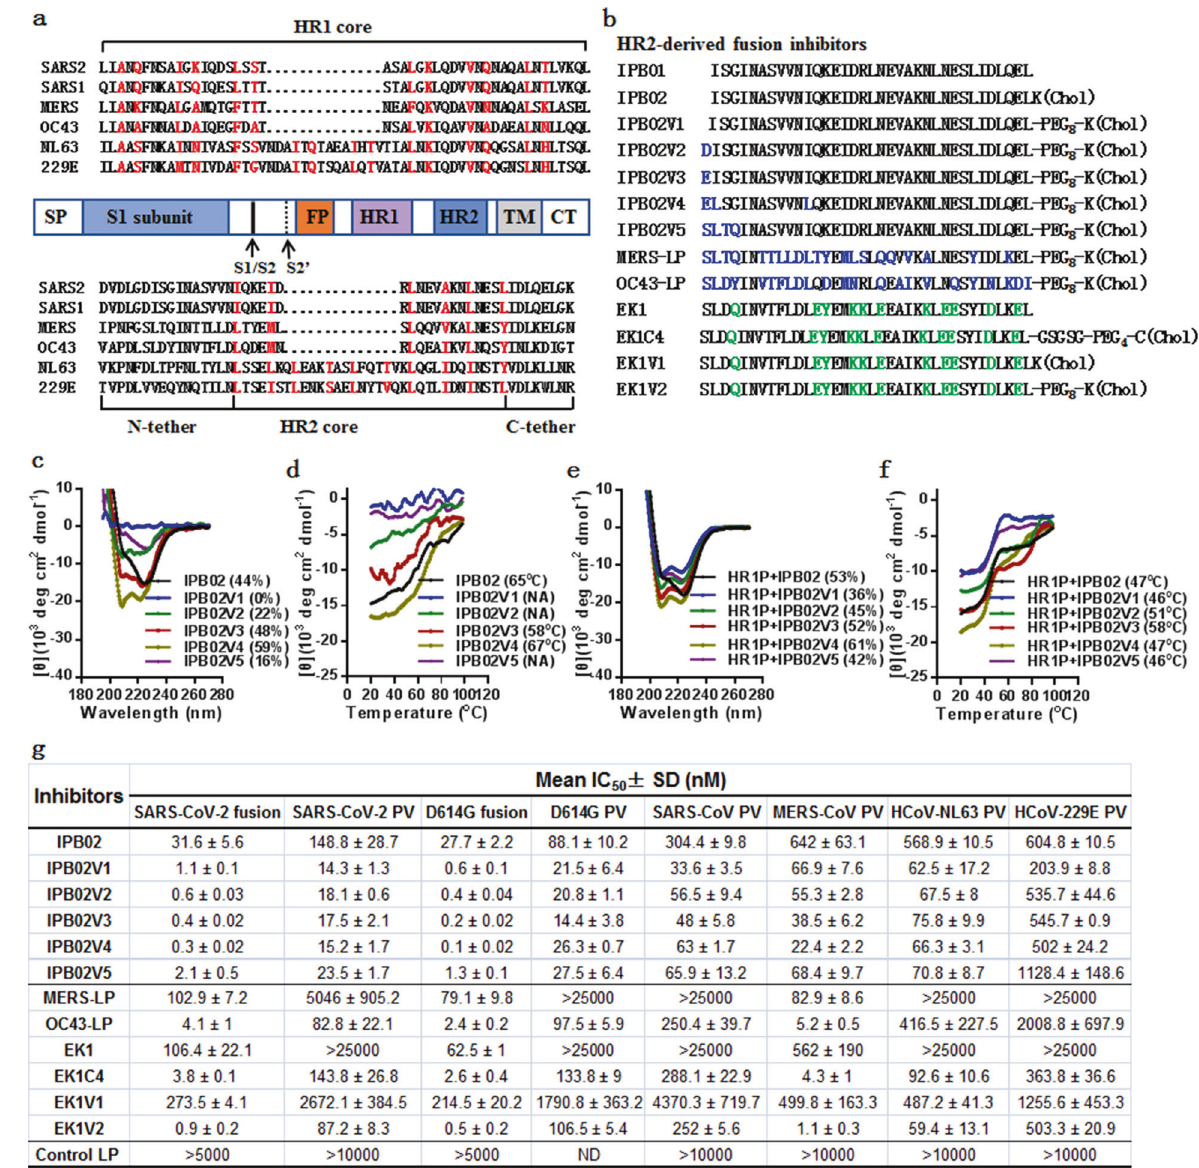
Fig. 1 Design and characterization of potent and broad-spectrum fusion inhibitors against divergent human coronaviruses. a Schematic diagram of functional domains of the S protein. SP signal peptide, FP fusion peptide, HR1 heptad repeat 1, HR2 heptad repeat 2, TM transmembrane domain, CT cytoplasmic tail. The S1/S2 and S2 ’ cleavage sites are marked with arrows. The HR1 and HR2 core sequences of representative HCoVs are listed, and the potential residues mediating the HR1 – HR2 interactions within the 6-HB core structure are colored in red. b HCoV HR2-derived fusion inhibitor peptides and lipopeptides. The residues marked in blue indicate the amino acid changes relative to the template sequence in IPB02. The residues in green indicate the amino acid changes relative to the template sequence in OC43-LP. Chol cholesterol, PEG 8 8-unit polyethylene glycol, PEG 4 4-unit polyethylene glycol, GSGSG a fl exible amino acid linker. c – f Secondary structure and binding stability of IPB02-based fusion inhibitor lipopeptides. The α -helicity and thermostability of lipopeptides alone ( c , d ) or in complexes with the SARS-CoV-2 HR1 target mimic peptide HR1P ( e , f ) were determined by CD spectroscopy, with the fi nal concentration of each lipopeptide being 10 μ M. The experiments were performed two times, and representative data are shown. g The inhibitory activity of various fusion inhibitors against SARS-CoV-2 and other human CoVs. Both dual-split-protein (DSP)-based cell – cell fusion assay and pseudovirus (PV)- based single infection assay were repeated three times, and data are expressed as the means ± standard deviations (SD). D614G represents the SARS-CoV-2 S protein-bearing D614G mutation and characterized. Interestingly, OC43-LP exhibited high inhibitory HCoV-229E pseudoviruses. Recently, the HCoV-OC43 HR2-derived potencies against all CoVs being tested; especially, it was a highly peptide EK1 and its lipid-derivative EK1C4 were reported as pan-CoV active inhibitor of MERS-CoV (Fig. 1g and Supplementary Fig. S5). fusion inhibitors. 5 To reveal the structure – activity relationship of Herein, the unconjugated EK1 peptide only showed weak inhibition various CoV fusion inhibitors, we further synthesized the lipopeptide on the SARS-CoVs-mediated fusion and MERS-CoV pseudovirus, and OC43-LP with the native HR2 sequence of HCoV-OC43. For no activity was observed against other pseudoviruses even at a high comparison, EK1 and EK1C4, as well as two new EK1-derivatives concentration (25,000 nM); nonetheless, the EK1C4 lipopeptide (EK1V1 and EK1V2) per our design strategy, were together produced